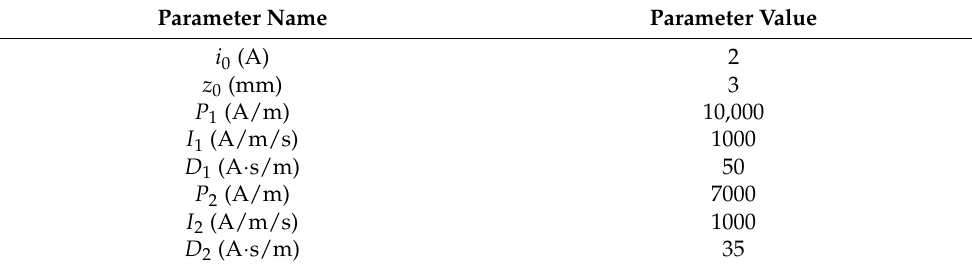
Table 5. Control parameters in the experiment.